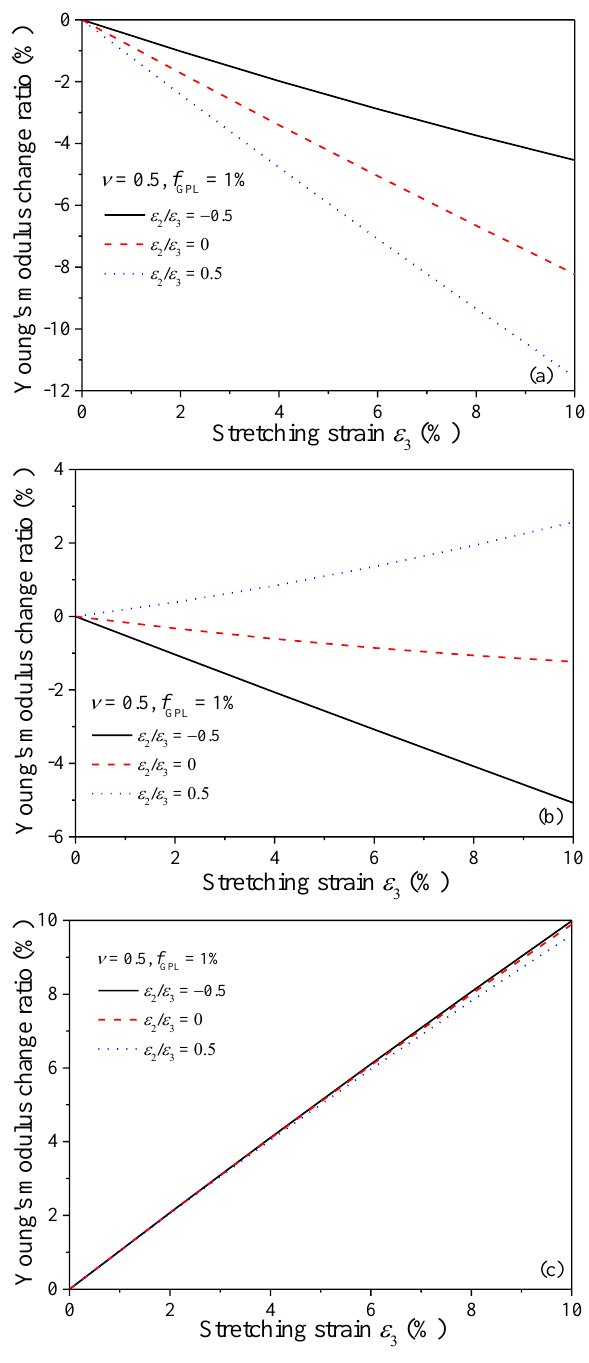
Figure 8. Variation of Young’s modulus change ratio of GPL/epoxy nanocomposites with stretching strain ε 3 ( a ) X 1 -direction; ( b ) X 2 -direction; ( c ) X 3 -direction.